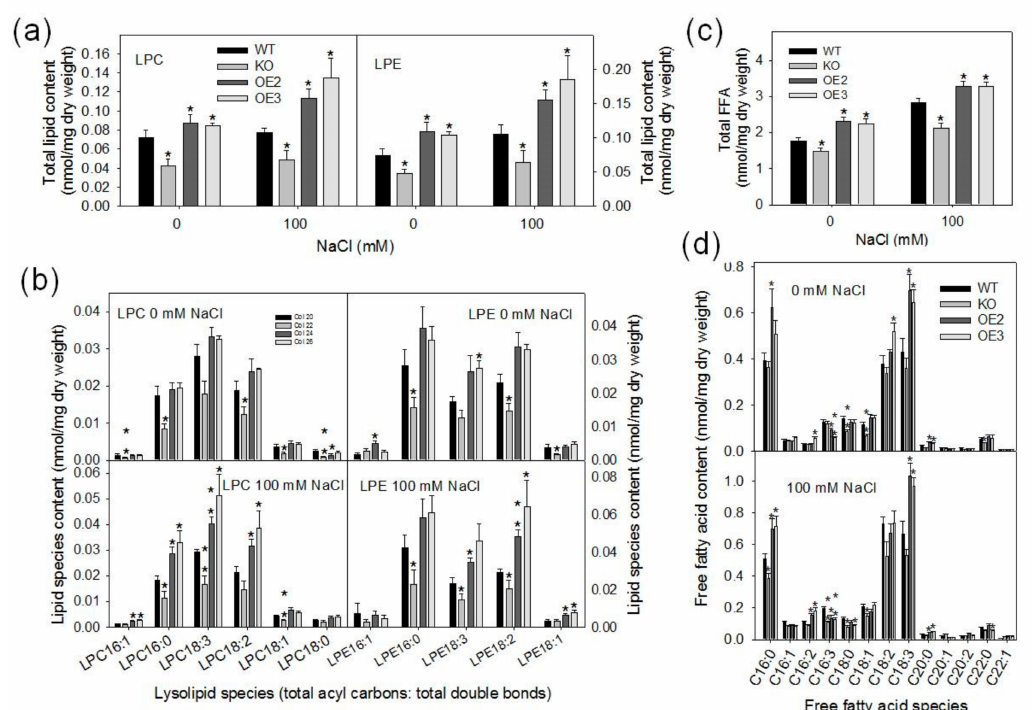
Figure 6. E ff ects of pPLAIII γ -KO and OE on lysophospholipid and free fatty acids (FFA) levels in Arabidopsis ; ( a ) total lysophospholipid content of LPC and LPE in WT, pPLAIII γ -KO and -OE seedlings; ( b ) lysophospholipid species in WT, KO and OE lines; ( c ) total FFA content in WT, KO and OE lines; ( d ) FFA molecules species in WT, KO and OE lines. Values are means ± SE ( n = 5 separate samples). Asterisks indicate significant di ff erences from WT by Student’s t-test at p =